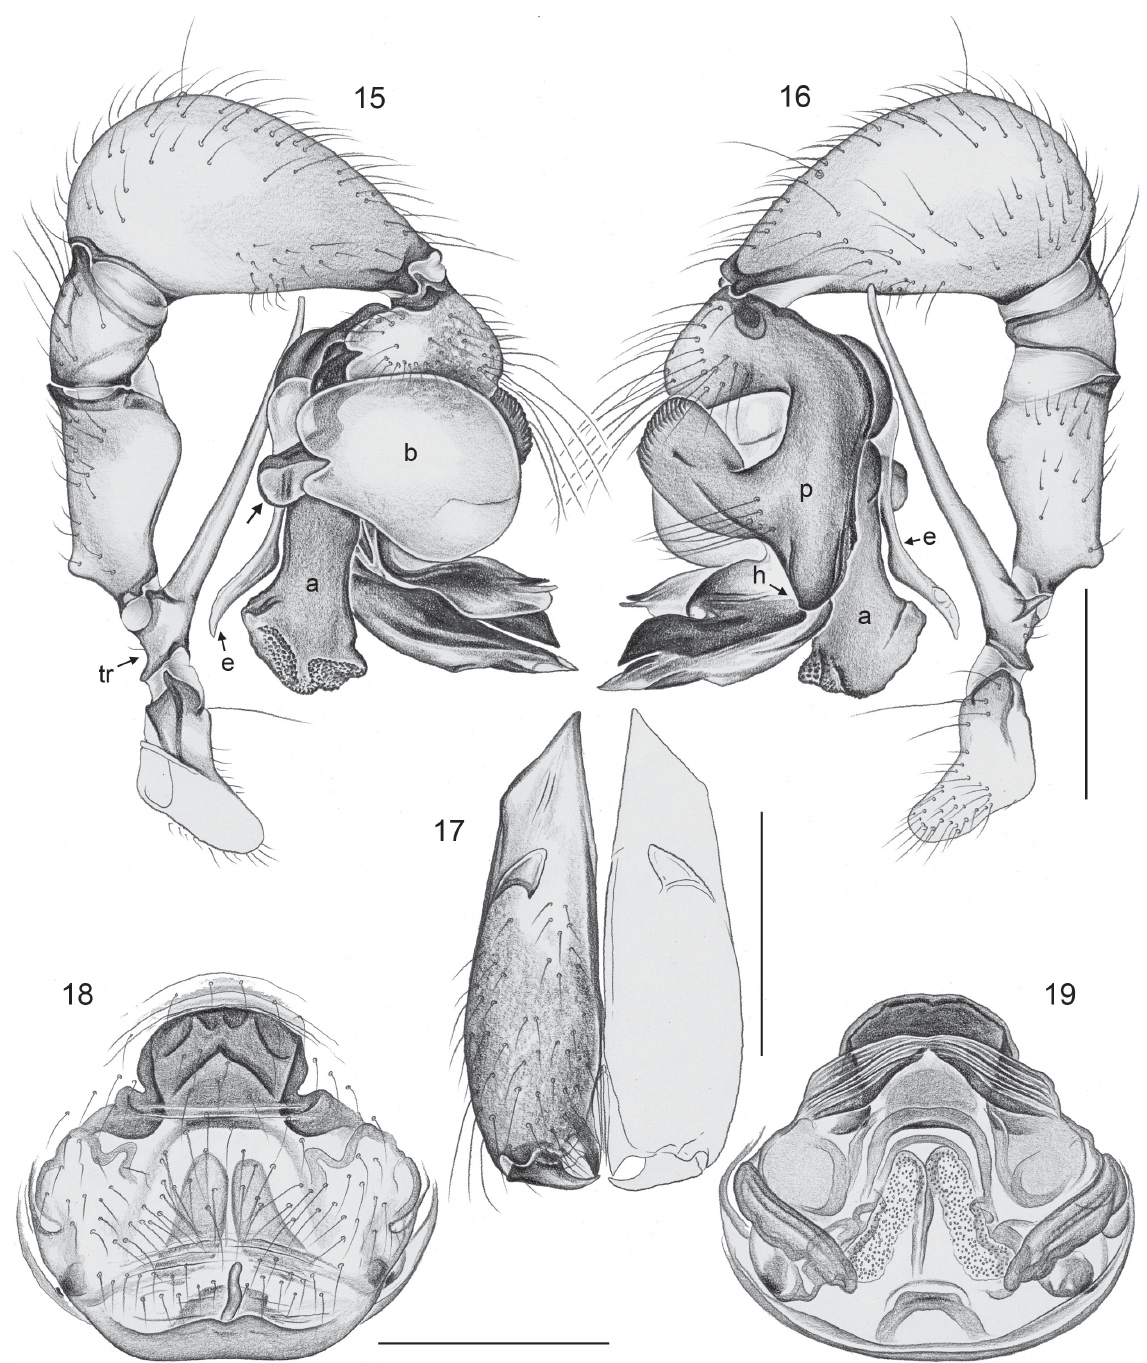
Figs 15–19. Pholcus uludong Huber sp. nov. (ZFMK, Ar 15695–96). 15–16 . Left male palp, prolateral and retrolateral views; arrow points at uncus-like process of proximal bulbal sclerite. 17 . Male chelicerae, frontal view. 18–19 . Cleared female genitalia, ventral and dorsal views. Scale bars: 15–16, 18–19 = 0.5 mm; 17 = 0.3